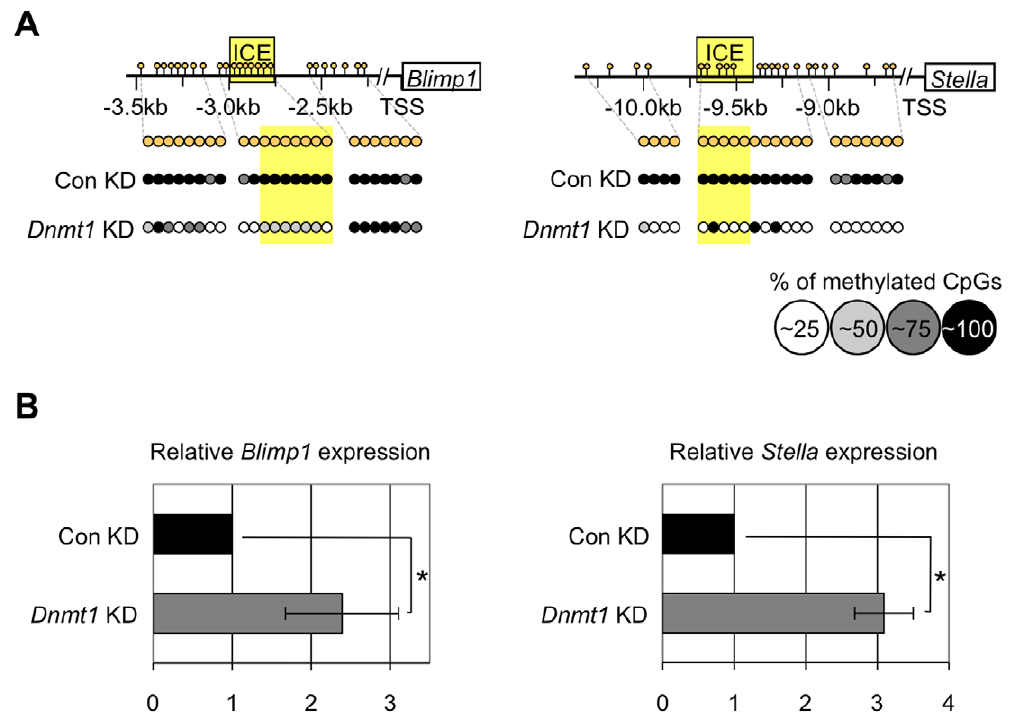
Figure 5. Knockdown of Dnmt1 causes hypomethylation of Blimp1 and Stella flanking regions and upregulation of Blimp1 and Stella expression in ES cells. (A) Bisulfite sequencing analysis of the flanking regions of Blimp1 and Stella and (B) quantitative RT-PCR analysis of Blimp1 and Stella expression were performed using ES cells with or without Dnmt1 knockdown treatment ( Dnmt1 KD/Con KD).